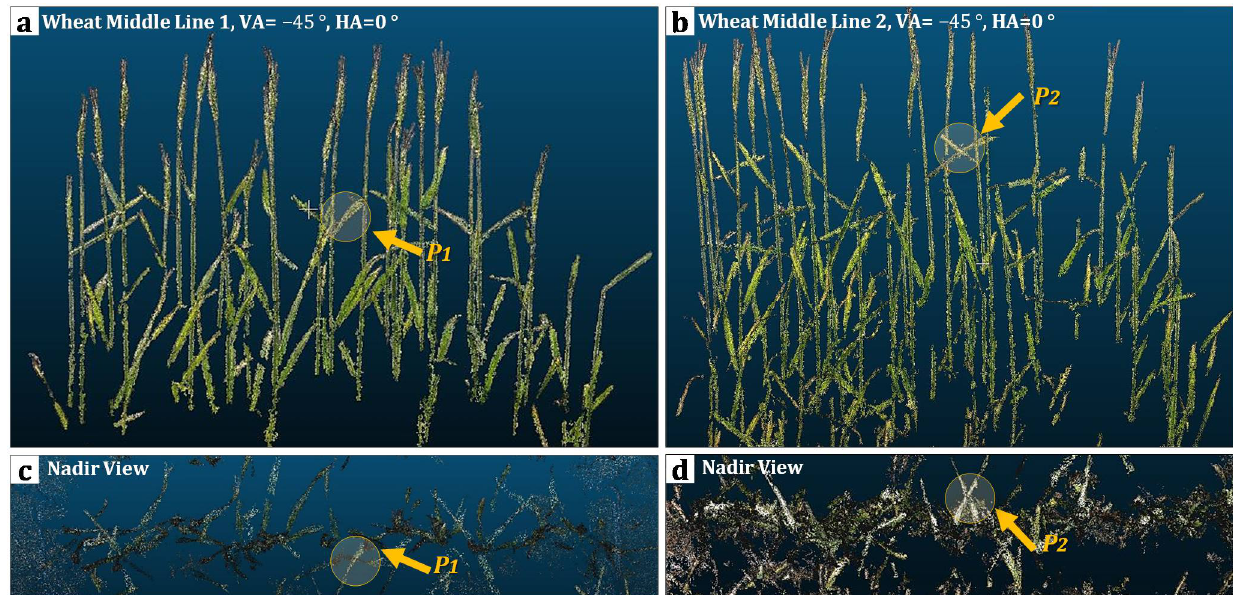
Figure 8. Demonstration of the 3D point clouds of the two samples of wheat leaves in the middle row of BBCH 69, showing front view resulted from the vertical angle of −45° and the horizontal angle of 0° ( a , b ), and the results of the camera setting in nadir view ( c , d ). Points P1 and P2 are samples.